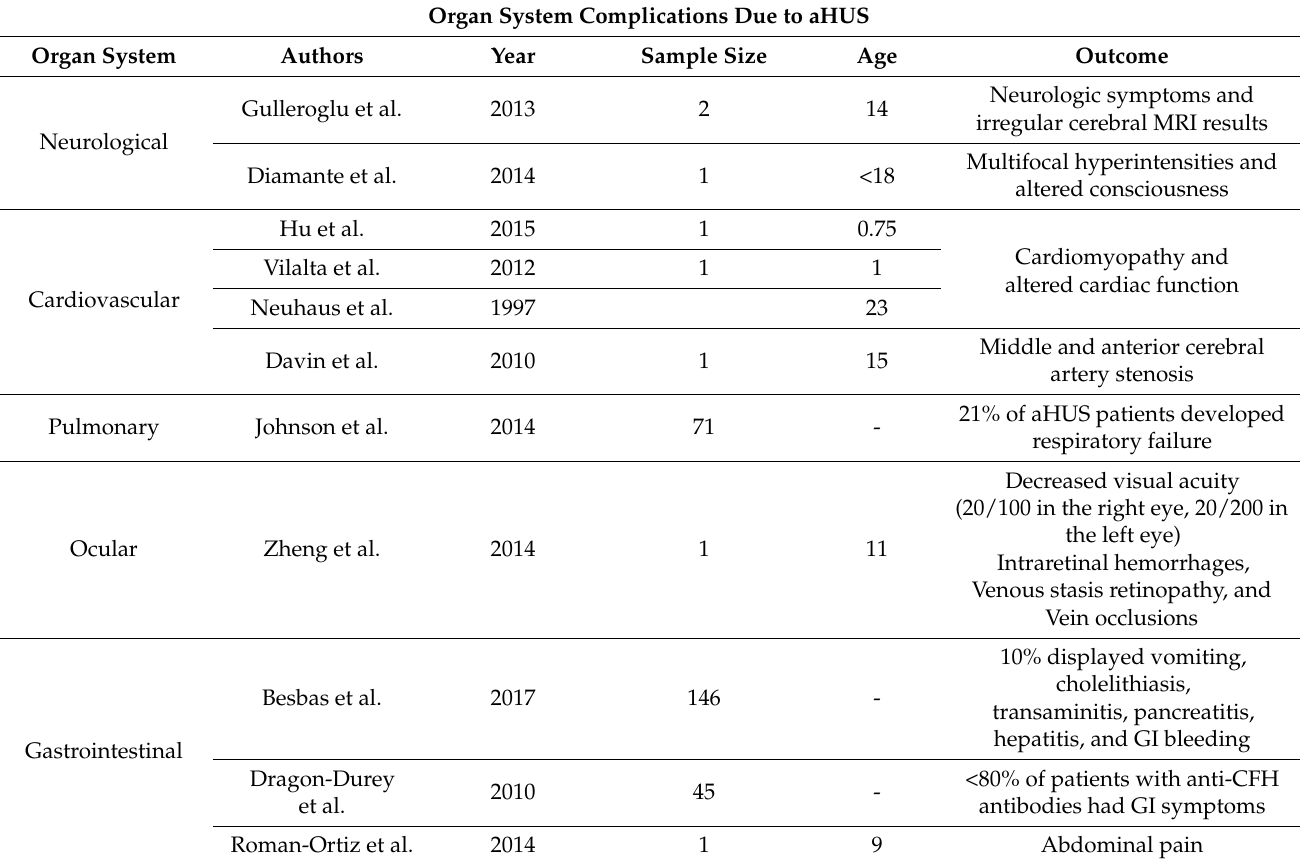
Table 4. Reports of organ system complications in